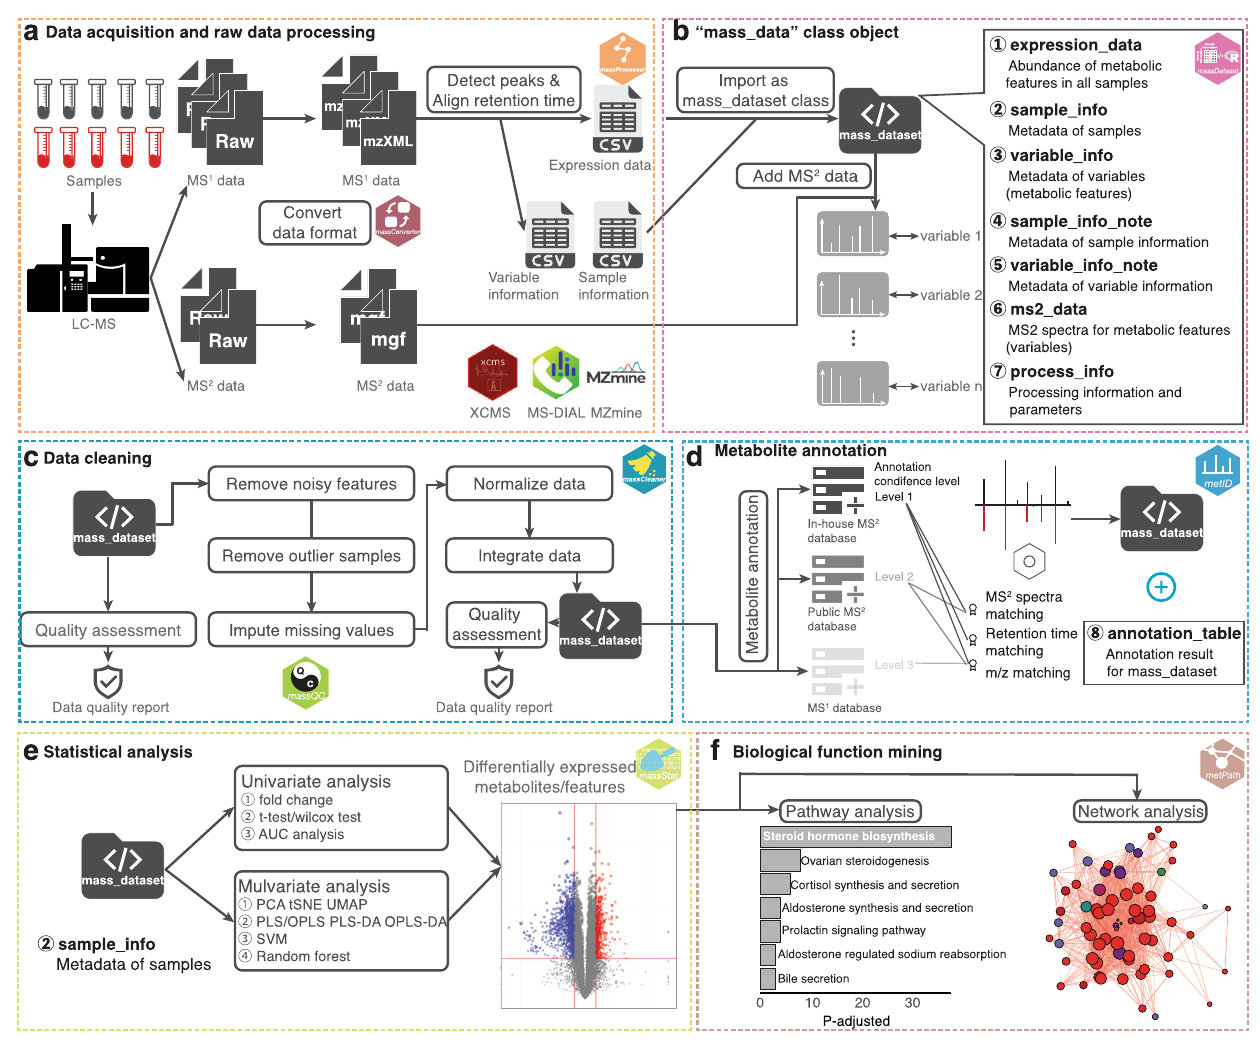
Fig. 3 | Analysis work fl ow of tidyMass. a Raw data processing using massCon- verter and massProcesser. b The “ mass_dataset ” class provides a uniform data structure and object-oriented work fl ow (in the massDataset package). c Data cleaning using massCleaner. d Metabolite annotation using metID. e Statistical